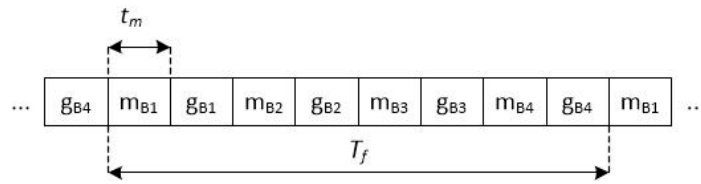
Figure 2. Frame structure.